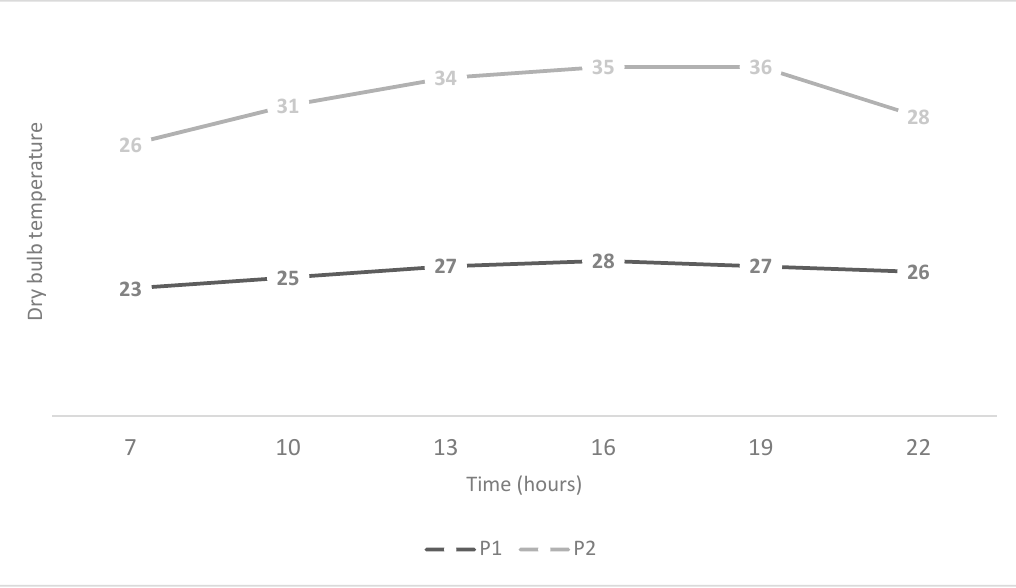
Figure 1 . Mean values of the dry bulb temperatures observed during P1 and P2 over the day. Figure 1. Mean values of the dry bulb temperatures observed during P1 and P2 over the